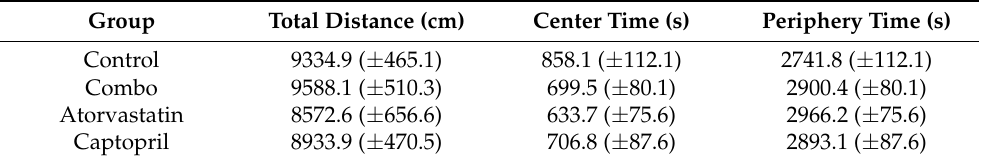
Table 2. Open field behavior in adult